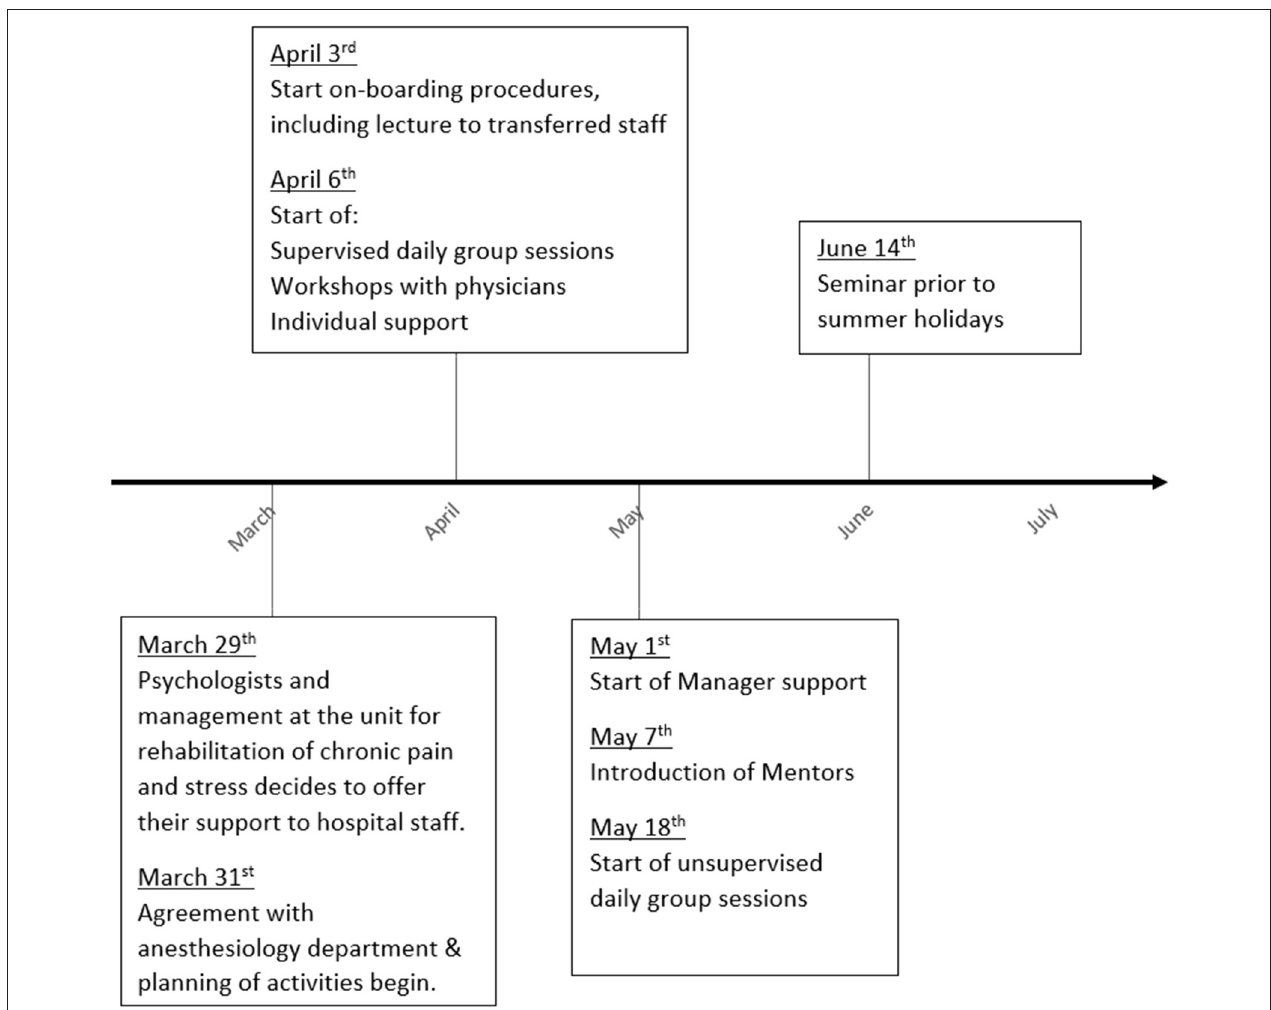
FIGURE 1 | Timeline over planning and implementation of the different support